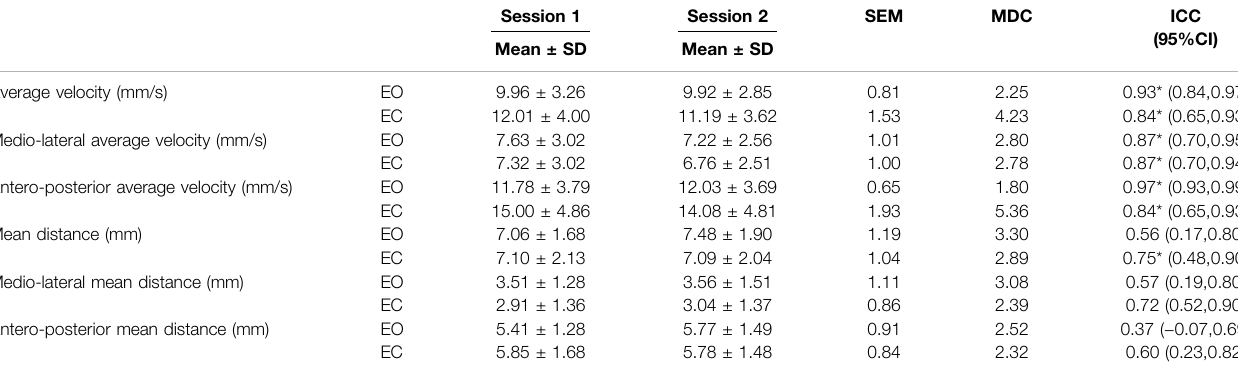
TABLE 1 | Within-day reliability for different COP variables in young participants.